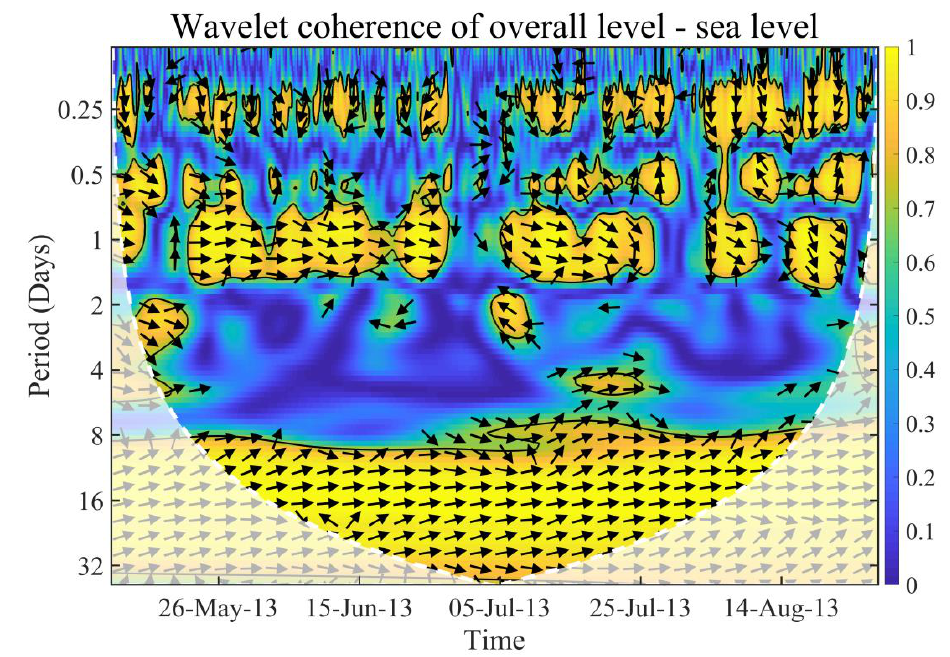
Figure 9. Wavelet coherence analysis of underwater noise (overall level) and sea level. The relative phase relationship is indicated with arrows as follows: pointing right, in-phase; pointing left, anti-phase; pointing straight down, sea level leading underwater noise by 90°. The 5% significance level again red noise is shown as a thick contour. The cone of influence (COI) where edge effects might distort the picture is shown as a lighter shade.